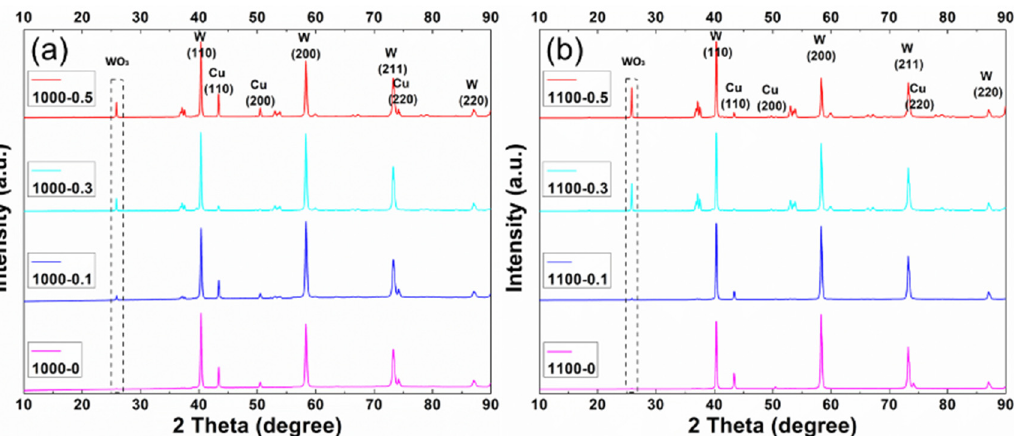
Figure 6. XRD spectra for Cu-W matrix composites with different loadings of GO, sintered at ( a ) 1000 °C and ( b ) 1100 °C. The labelled peaks are from W and Cu, and the other unlabelled peaks are from WO 3 , with the main reflection from WO 3 is highlighted to the dotted boxes. Figure S11 gives the reference X-ray reflections for Cu, W and WO 3 .